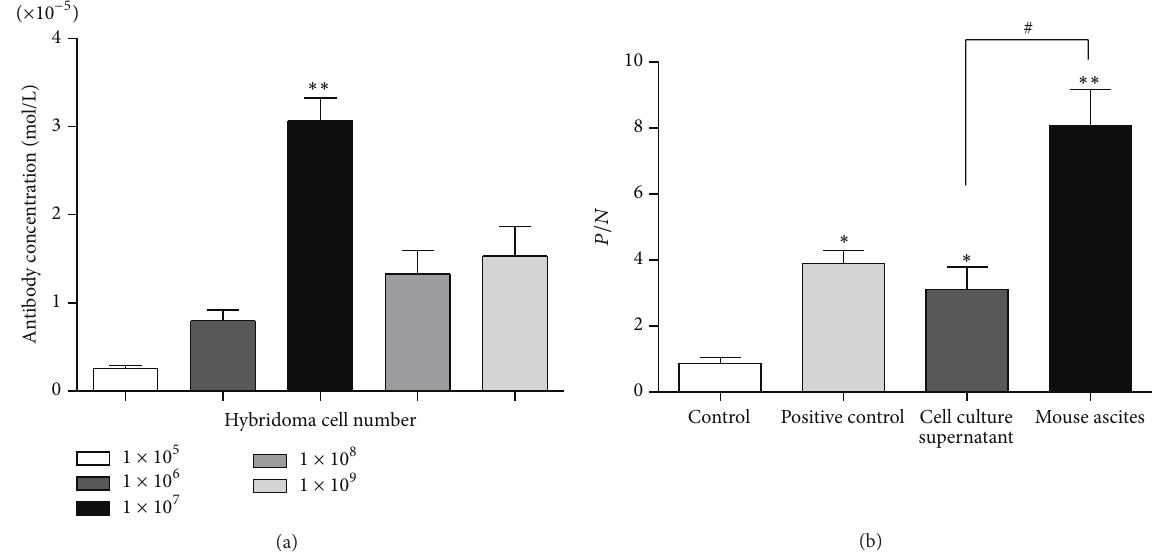
Figure 1: Concentration of AT1-mAb purified from mouse ascites was higher than that from hybridoma supernatant. (a) Concentration of monoclonal antibody that was purified from mouse ascites ( ∗∗ 𝑃 < 0.01 versus 1 × 10 −5 , 1 × 10 −6 , 1 × 10 −8 , and 1 × 10 −9 , 𝑛 = 8 ). (b) Content of AT1-mAb that was purified from the cellular supernatant of hybridomas compared with that from mouse ascites, and positive control was the AT1-AA purified from preeclampsia sera. # 𝑃 < 0.05 versus cellular supernatant; ∗ 𝑃 < 0.05 versus control; ∗∗ 𝑃 < 0.01 versus control. Data represent the mean ± SEM; 𝑛 = 8